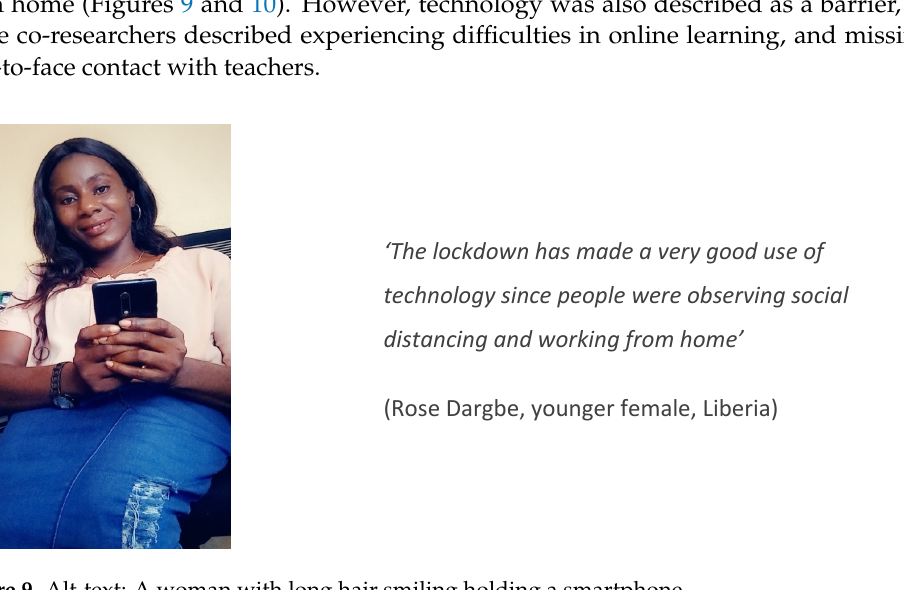
‘Online classes started in April last year. After looking at the mobile or laptop screen for one and a half to two hours, can Figure 10. Alt-text: A desk with notes, pens and pencils and an online class being streamed on a phone. 5.5. Accessibility and Awareness Accessibility to and comprehension of COVID-19 messaging, either due to hearing impairments or cognitive capacity to act, were barriers across co-researchers. Inaccessibility was mentioned in terms of both communication and mobility. Co- researchers in Liberia mentioned how masks can often isolate the deaf community, as it is difficult to lip read or see facial expressions as mentioned by Rose in Figure 11. Barriers to accessing public health information was also highlighted, as many health messages were broadcast on radios and tv without any interpreters. Fatema, a young female caregiver in Bangladesh, expressed her fears, as her sister-in-law with learning disabilities refused to wear a mask, as she did not understand COVID-19 precautions. students keep full concentration on the online classes? I cannot do it. In the offline classes, we attended the class in person in front of the teachers. By looking student’s faces, the teachers could also see whether students have understood the work but in online classes, this is not possible.’ (Marjana Binte Forhad, 22-year-old female, Faridpur, Bangladesh)